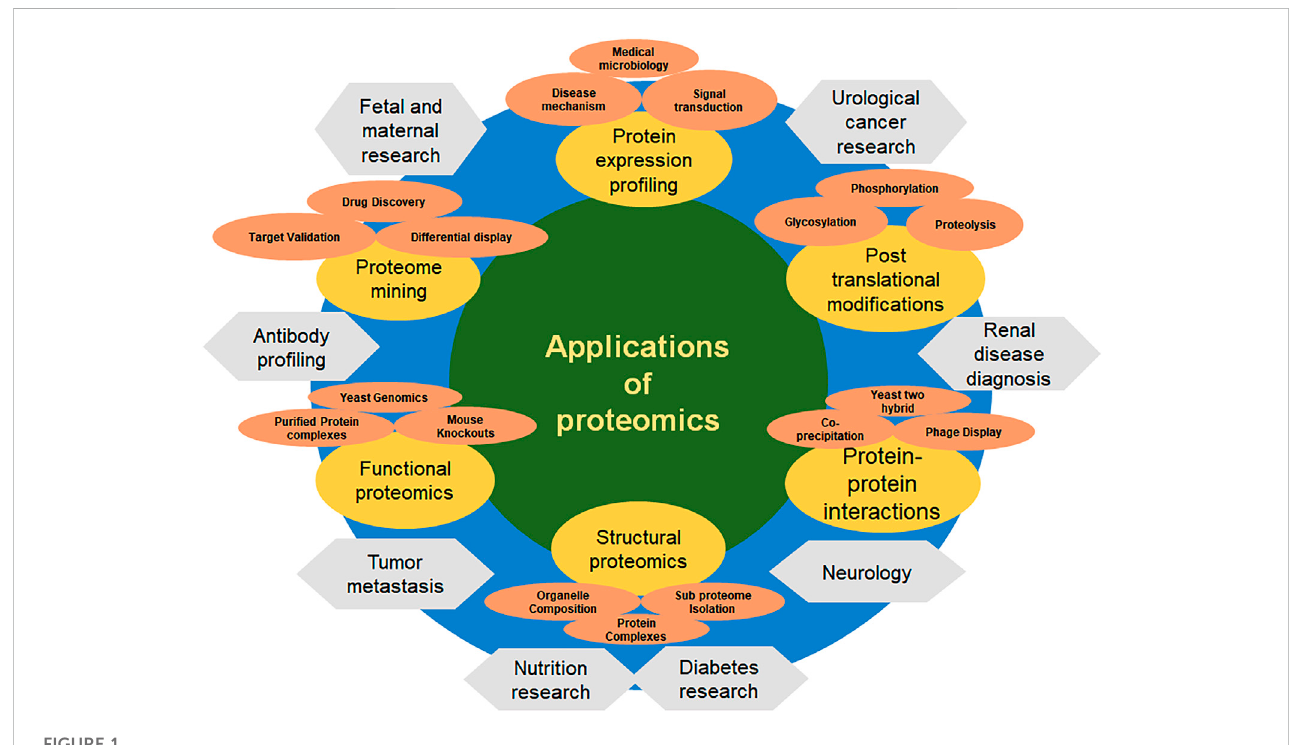
FIGURE 1 Applications of